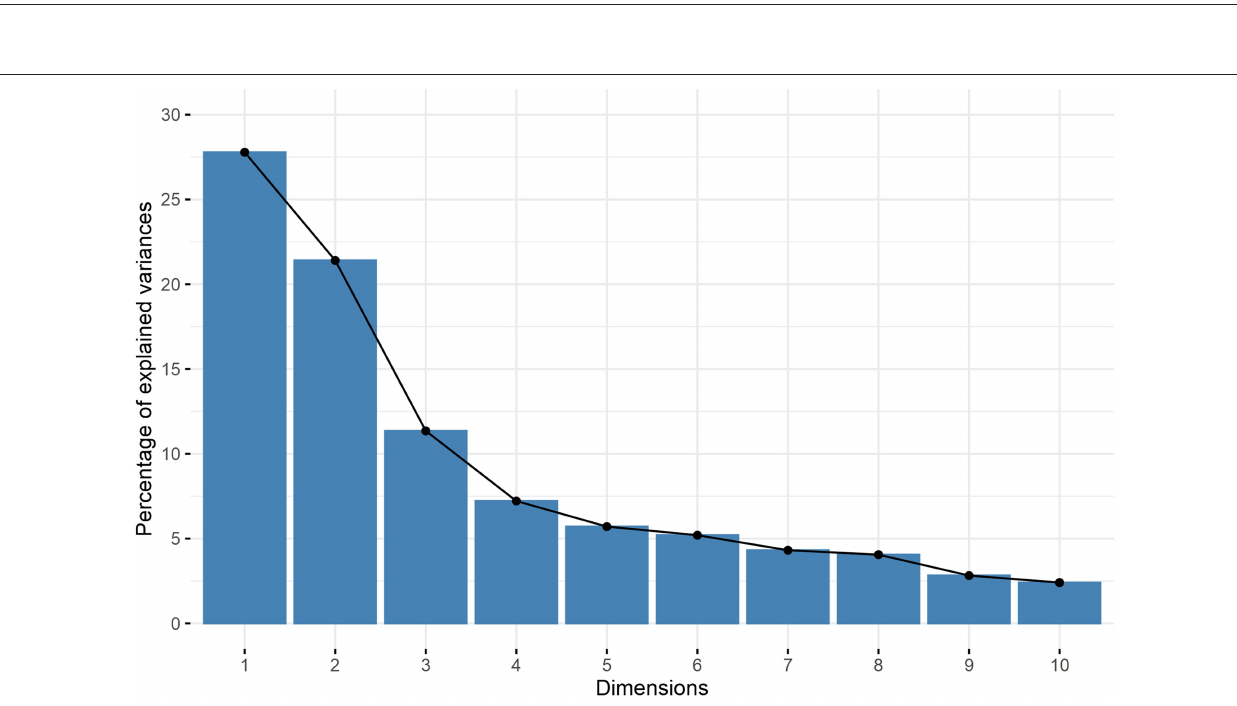
Frontiers in Veterinary Science |